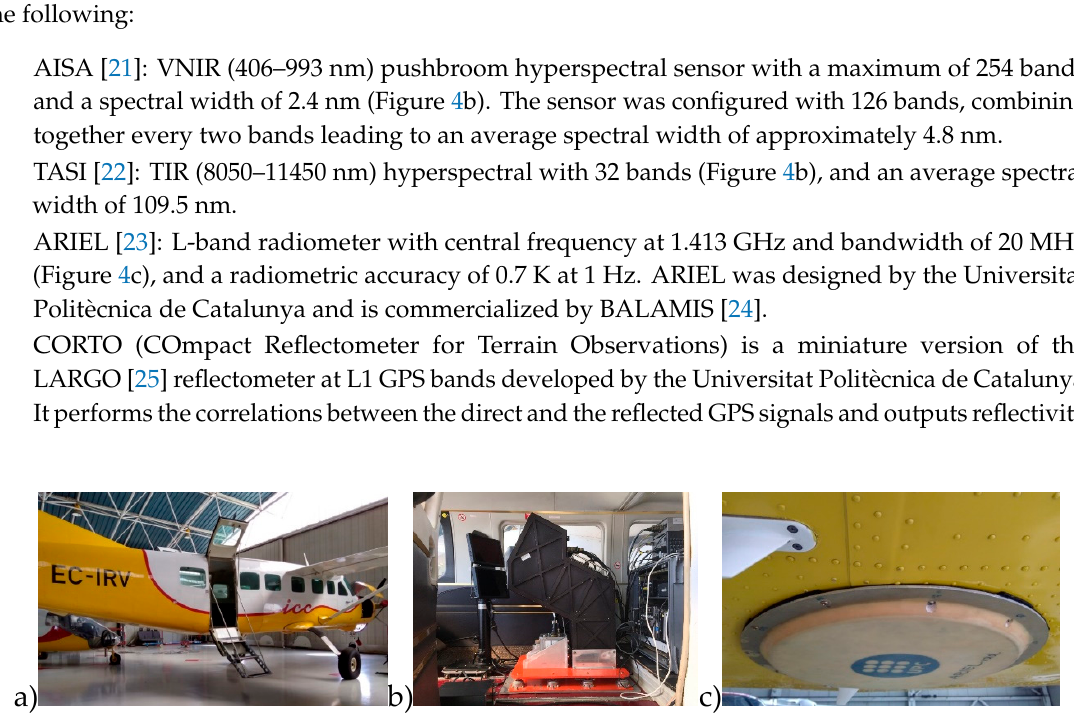
Figure 4. Experiment instrumentation: ( a ) CESSNA Caravan plane, ( b ) AISA (hyperspectral VNIR) and TASI (TIR), and ( c ) ARIEL L-band radiometer.